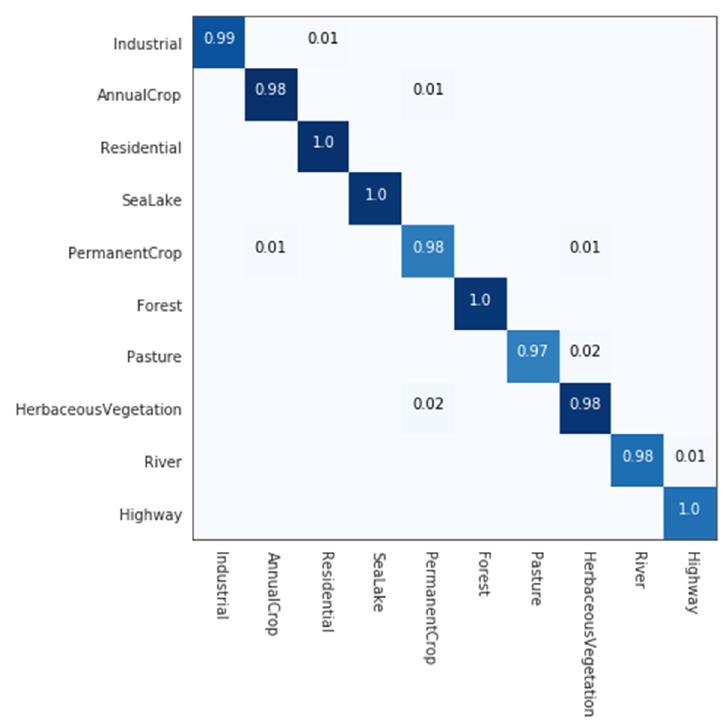
Figure 9. Confusion matrices of DDRL-AM framework with 80% training data of EuroSAT. The results in Figure 9 correspond to results shown in Table 5.